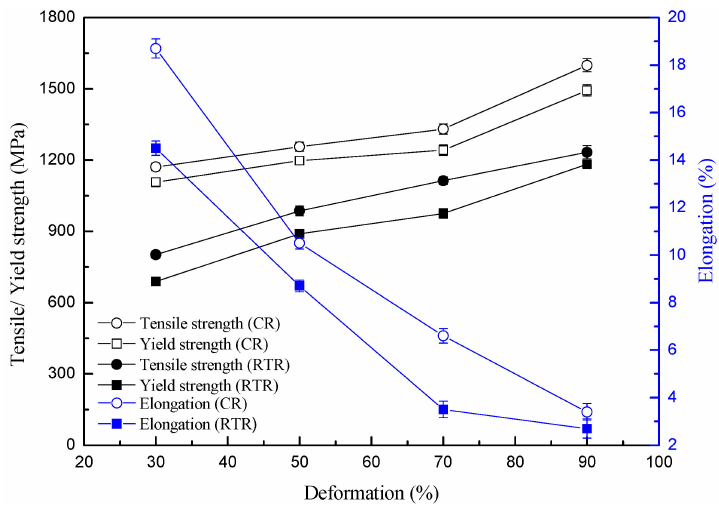
Figure 5. Relationship of the strength and elongation with deformations at different temperatures (the data of CR is from